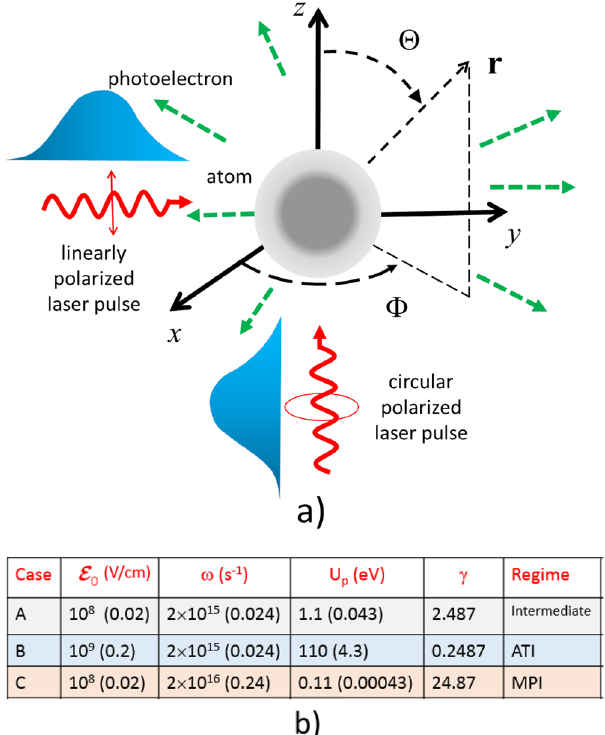
Figure 1. ( a ) Illustration showing the directions of the linearly polarized and circularly polarized laser pulses with respect to a spherical coordinate system. The directionality of the photoelectron is defined by the angles Θ and Φ . The numbers in the brackets are in atomic units (a.u.). ( b ) Table showing the 3 cases characterized by  and frequency ω : A (intermediate regime), B (ATI regime), C Keldysh parameter γ for laser field amplitude 0 9 1 and ω = − 10 s 16 1 has the same γ as case A and therefore gives the (MPI regime). The case of  = − 10 Vcm 0 same spectral distributions as case A except with higher